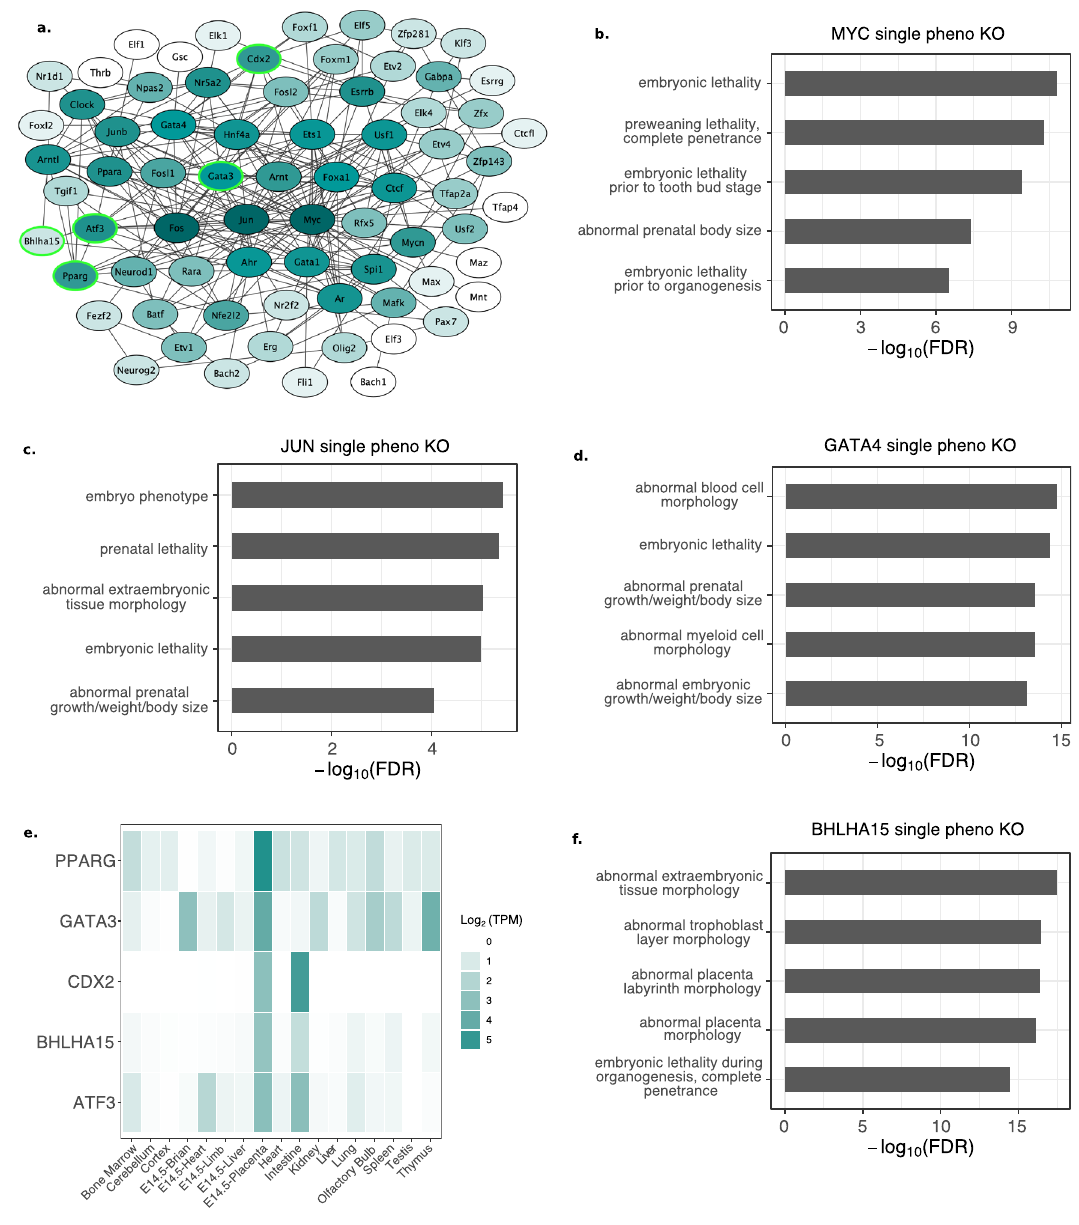
Figure 4. Transcription factors enriched in active enhancers. ( a ) Protein–protein interaction network comprised of TFs enriched within AE state intergenic or intronic regions. The darker the color, the higher the number of connections (edges). Light green outline indicates a gene with placenta-specific expression as defined by TissueEnrich. ( b ) The MYC TF targets genes are associated with embryonic lethality and prenatal size. ( c ) The JUN TF targets genes are associated with embryonic lethality and size. ( d ) The GATA4 TF targets genes associated with embryonic size, embryonic lethality, and cell morphology. ( e ) TissueEnrich heatmap showing the genes that have placenta-specific gene expression patterns. ( f ) The BHLHA15 TF targets genes associated with placental